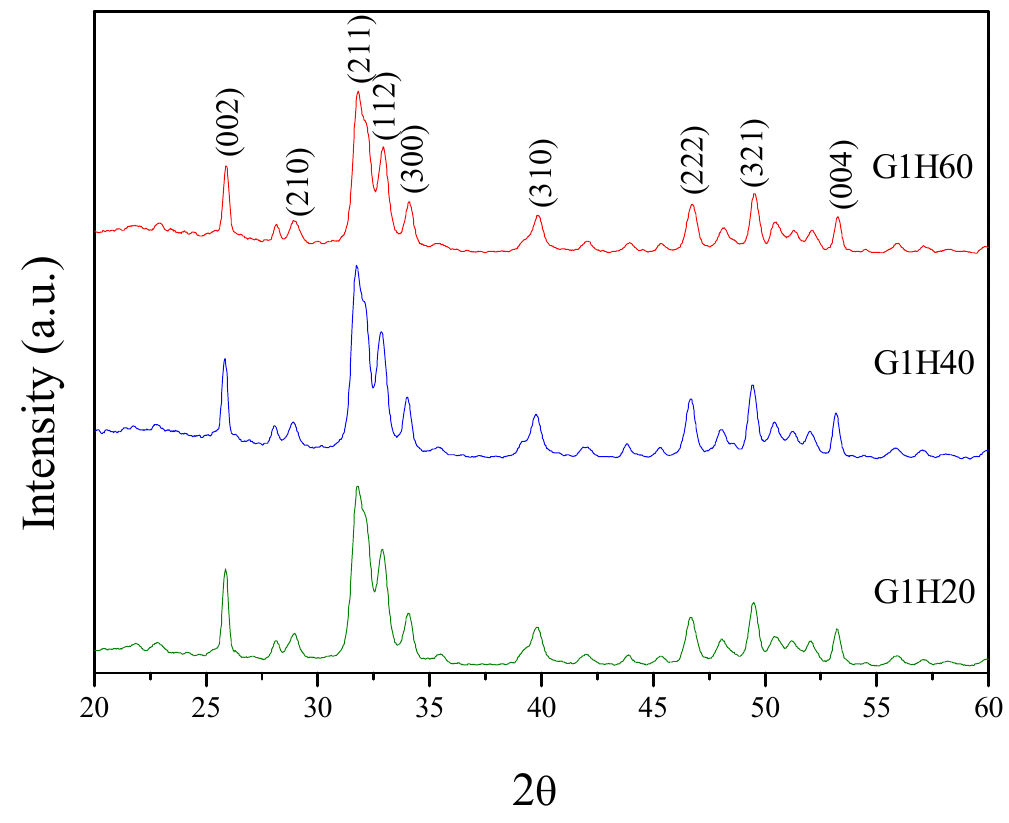
Figure 3. Powder X-ray diffraction (XRD) patterns of PGA-AP nanoparticles. The particle sizes of G1H20, G1H40 and G1H60 measured by DLS were 79.7 ± 1.6, 88.5 ± 0.8 and 92.8 ± 2.3 nm, respectively, indicating they increased significantly with de- creasing the γ-PGA content ( P <